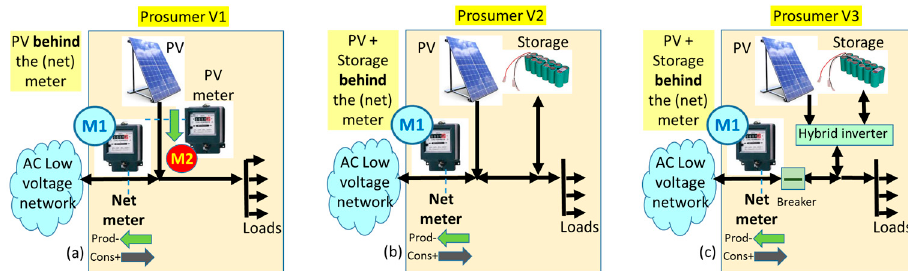
Figure 2. Usual architectures for today’s prosumers: ( a ) PV behind the meter connected on the AC internal network and directly connected to the distribution system operator (DSO) grid; ( b ) PV and storage behind the (net) meter connected to the AC grid operated by DSO; ( c ) PV and storage behind the (net) meter connected through a hybrid inverter that allows supply of the loads in the islanding mode of operation.